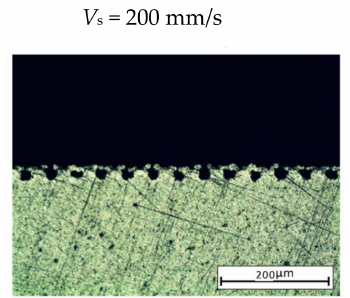
Figure 5. Evolution of texturized grooves geometry as a function of V s .